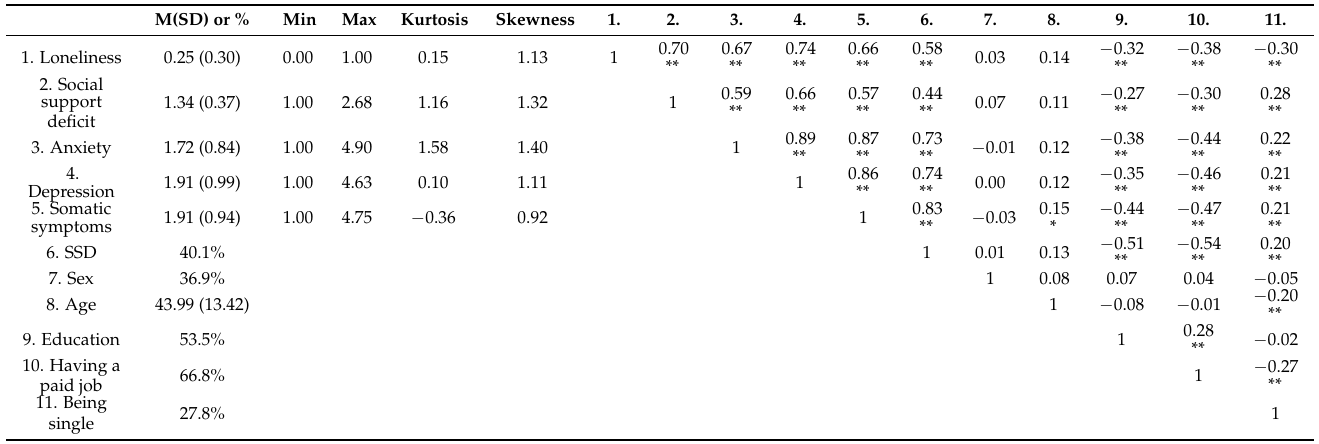
Table 1. Descriptives and correlations of the measures included in the analyses.